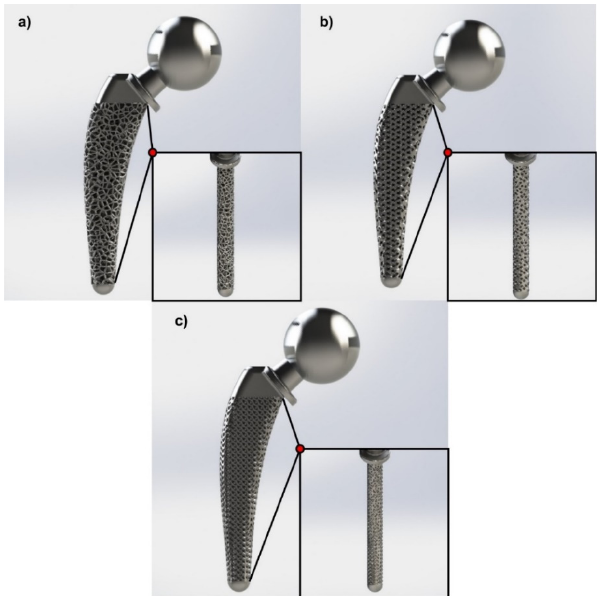
Figure6. Optimizedhipimplantdesignsvialatticestructures: ( a )Voronoi;( b )Gyroid;( c )SchwarzDiamond. Figure 6. Optimized hip implant designs via lattice structures: ( a ) Voronoi; ( b ) Gyroid; ( c ) Schwarz Diamond.